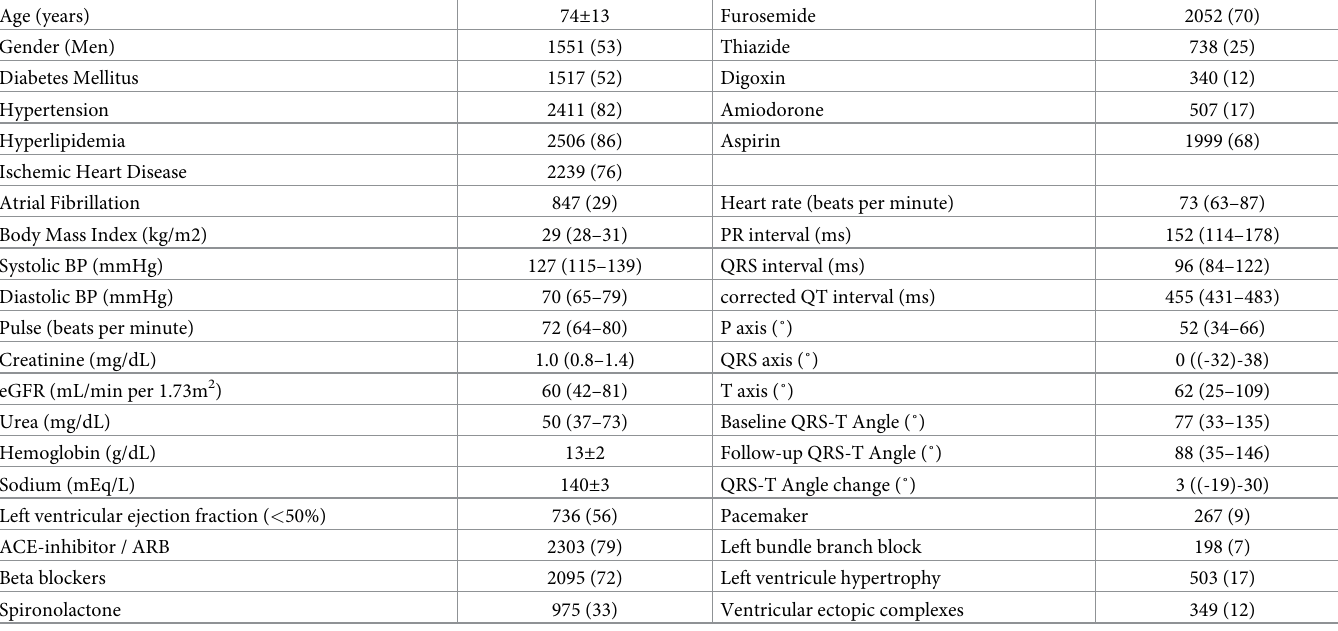
Table 1. Demographics and clinical characteristics of the